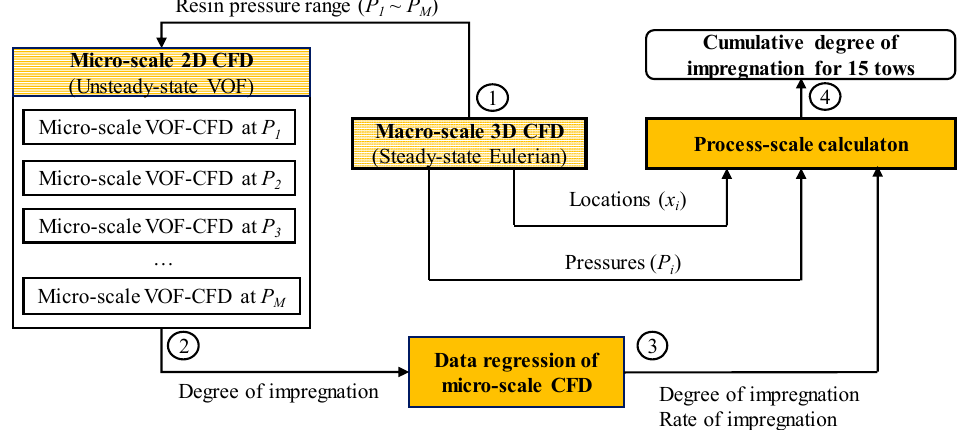
Figure 6. Sequential coupling strategy of multiscale CFD simulation to predict the permeability of resin through porous tows for the production of thermoplastic carbon fibers (modified from Ngo et al. (2017) [29]).